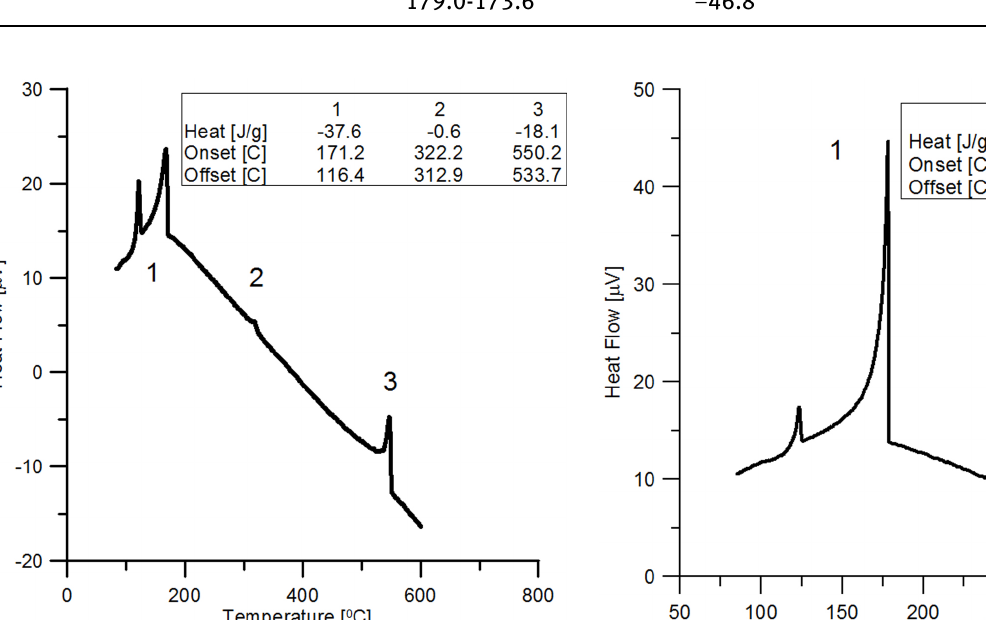
Figure 5: DSC curve of the alloy no